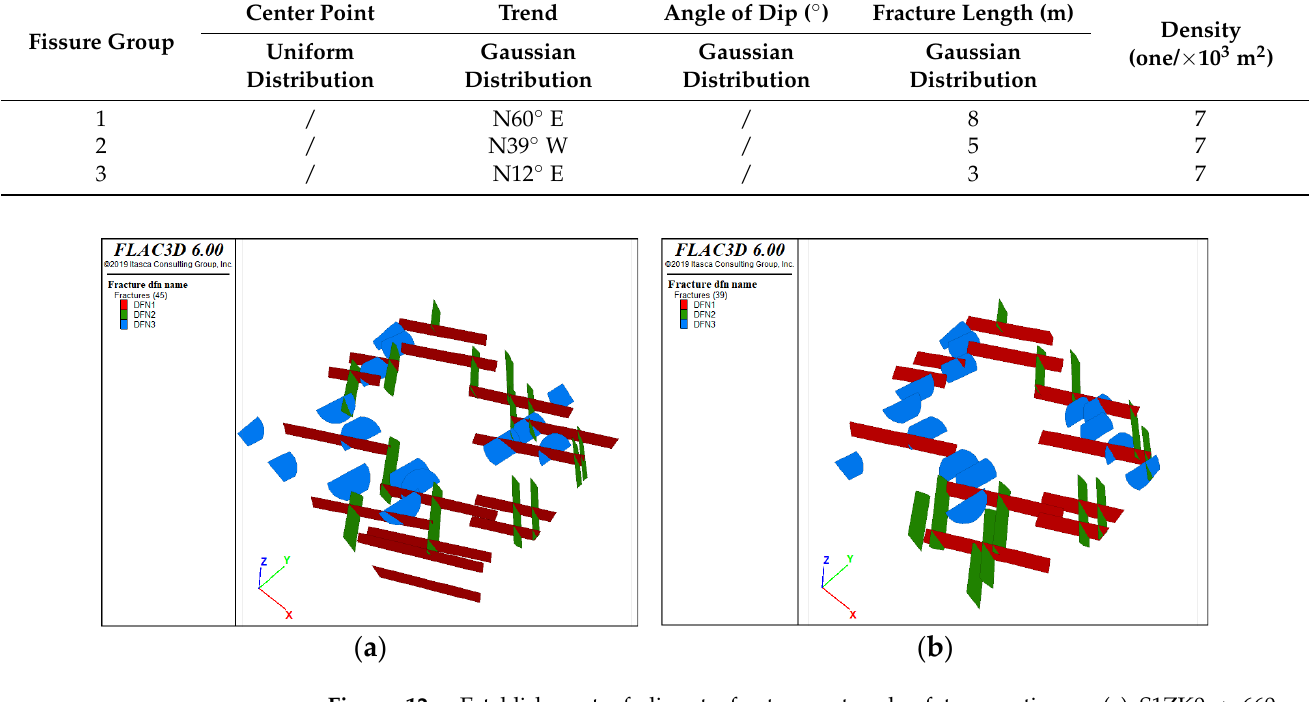
Figure 12. Establishment of discrete fracture network of two sections. ( a ) S1ZK0 + 660 m; ( b ) S1ZK0 + 735 m.